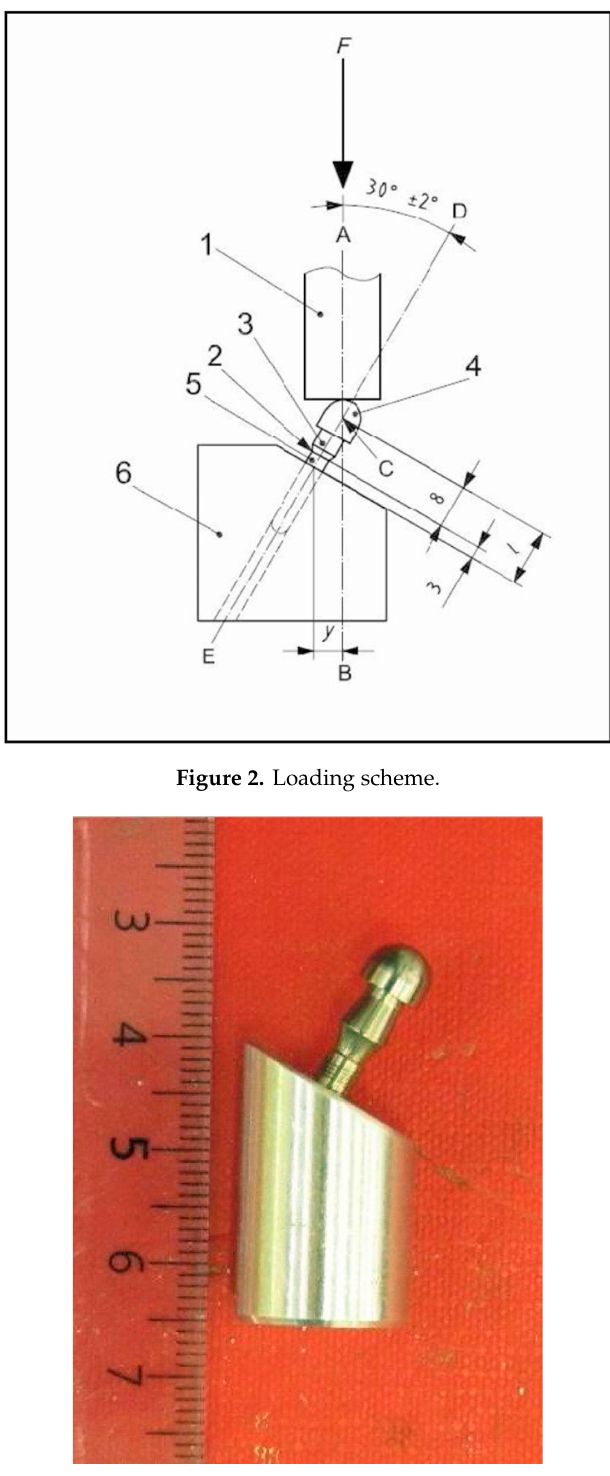
Figure 3. Sample before testing.